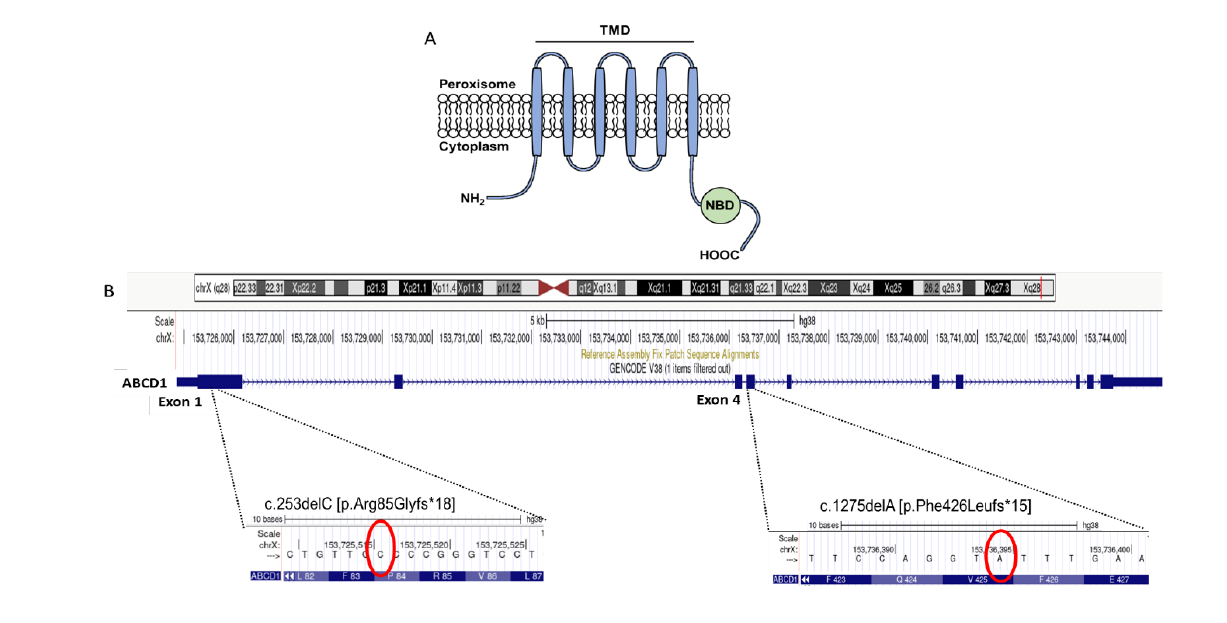
Figure 3. Product of the ABCD1 gene encodes a transmembrane protein composed of a transmem- brane domain (TMD) and a nucleotide binding domain (NBD) responsible for import of VLFCA from cytosol into peroxisomes ( A ). Chromosomal location of the novel frameshift mutations c.253delC in exon 1 and c.1275delA in exon 4 in the ABCD1 gene on the X-choromosome ( B ).